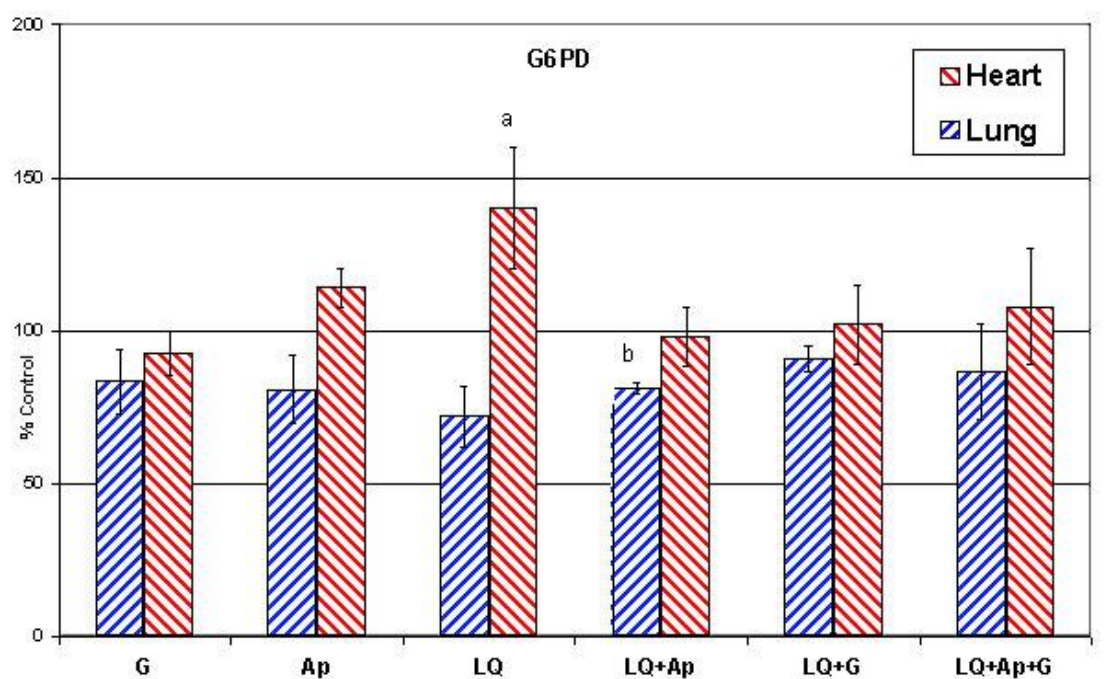
Figure 4: Effects of Leiurus quinquestriatus venom (LQ) alone or after pretreatment with Ginkgo biloba extract (G) and/or aprotinin (Ap) on glucose-6-phosphate dehydrogenase activity (G6PD) in the cytosolic fraction of the rat heart and lung